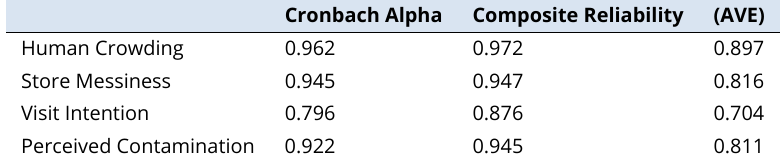
Table 2 indicates that all the items load on their respective variables, and the values are well above the acceptable threshold value, i.e. 0.70. Hence, the first criteria to assess the reflective outer model was